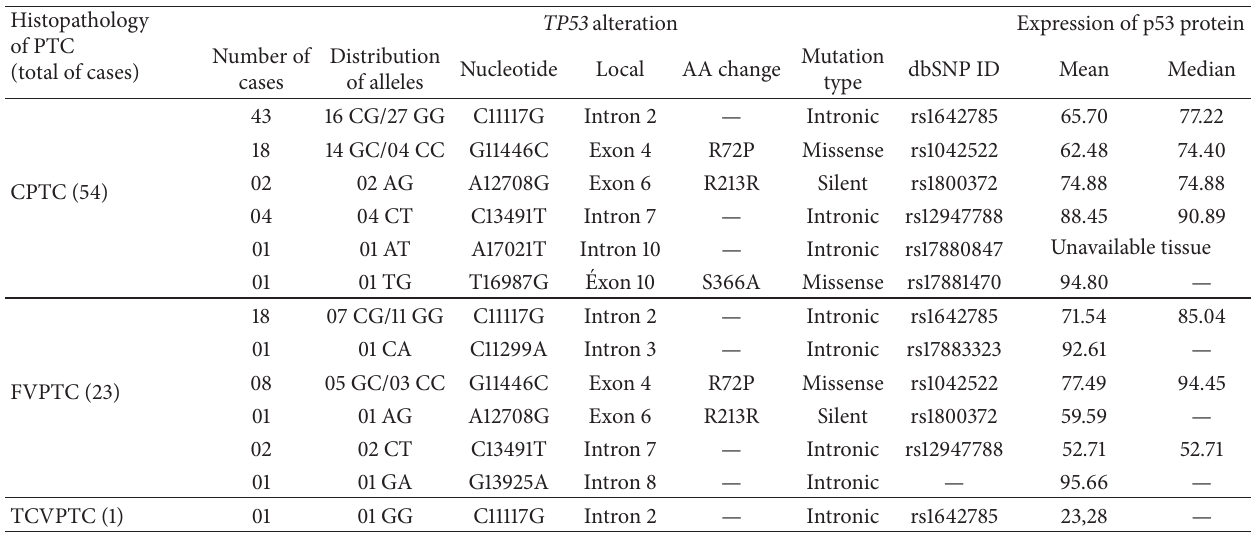
Table 3: TP53 genetic alterations in PTC patients, according to histopathological subtypes and the mean p53 protein expression quantified with the automated cellular imaging system ACIS-III.